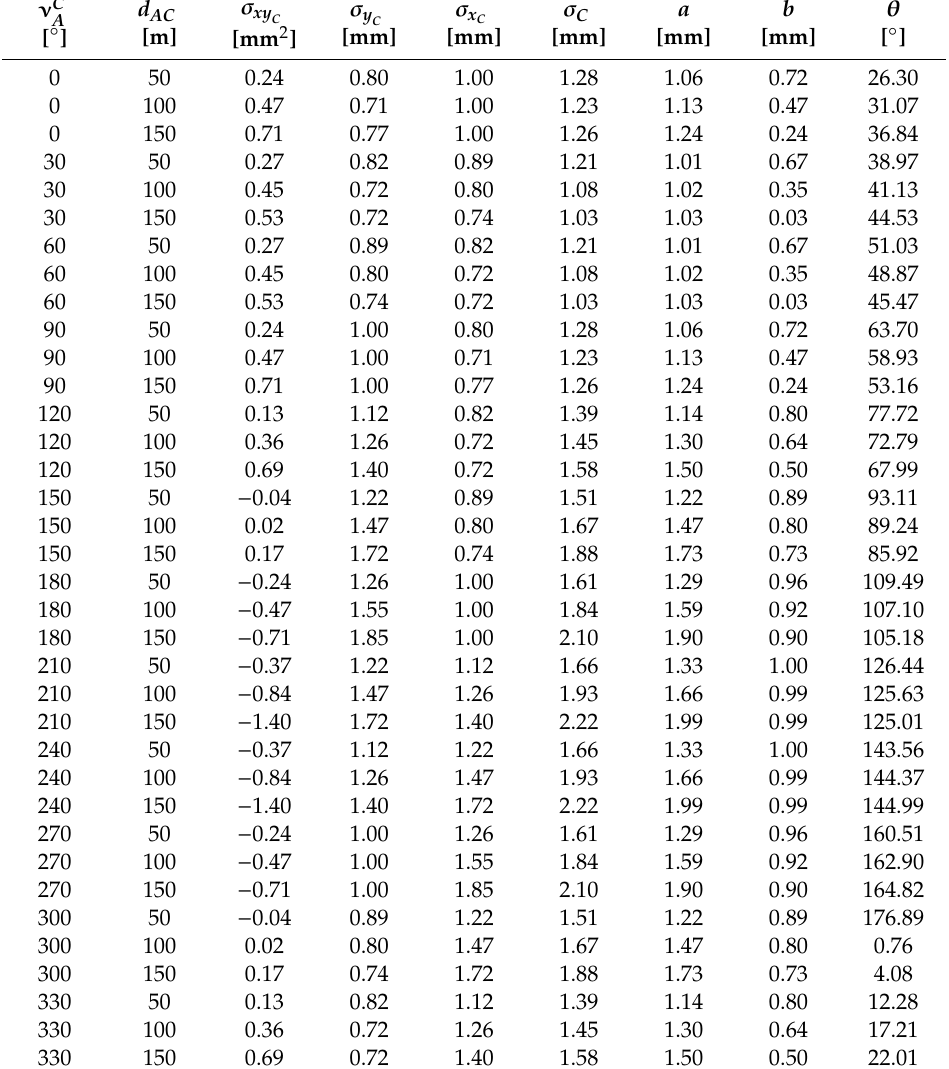
Table 2. The precision of the position of the control point C and the elements of the standard error ellipse due to the temperature displacements at the survey point A